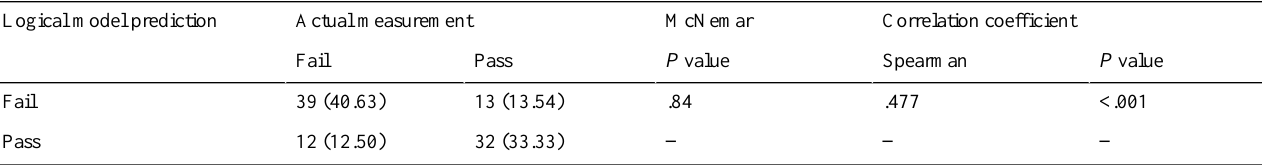
Table 5. Comparison of the pass/fail results of the 3000-meter empty-handed run predicted by the logistic model with actual measured